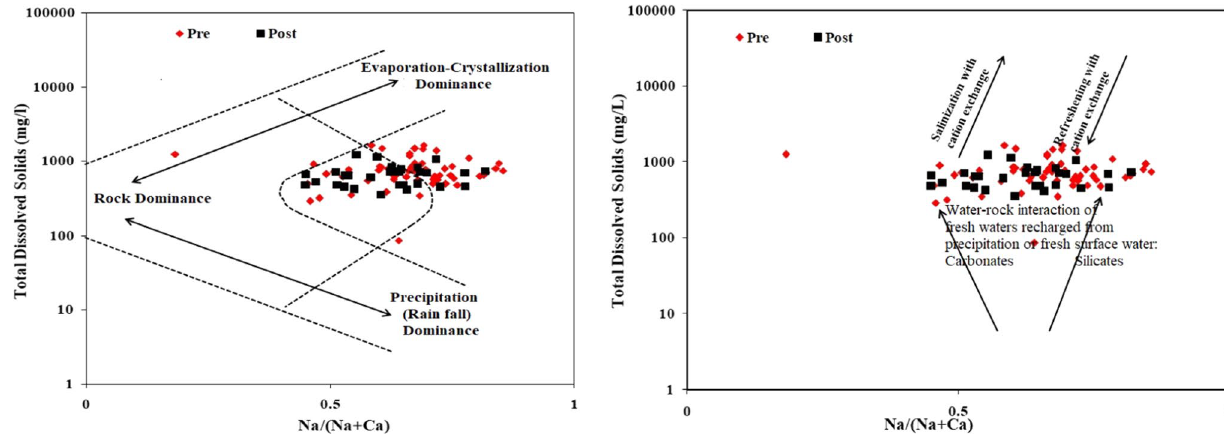
Fig. 11 Gibb’s plot from the study area is rock-dominant factor controlling the groundwater chemistry in pre and post-monsoon